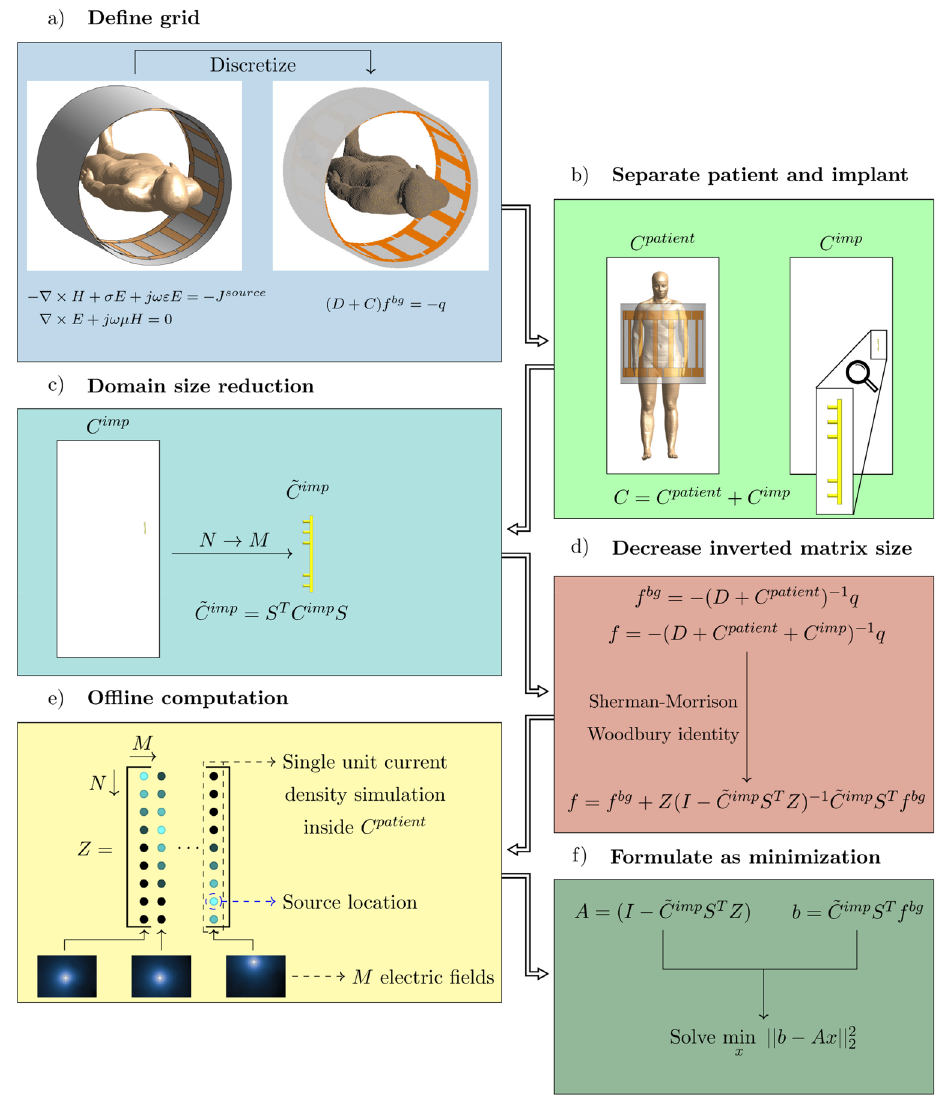
Figure 2. Schematic visualization of the prior method still using the library matrix. ( a ) The RF coil, patient anatomy, and the implant are discretized on a cubic grid. ( b ) The dielectric of patient anatomy and the implant are separated. ( c ) The implant is only present on a small domain in the simulation, therefore we can decrease the domain size of the computation to only those locations where the implant is present. ( d ) using the Sherman–